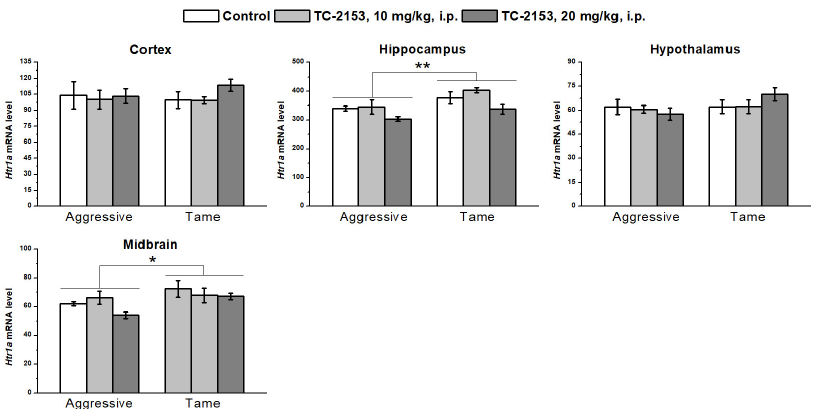
Figure 5. Effects of acute administration of vehicle (control) or TC-2153 at a dose of 10 or 20 mg/kg on 5-HT 1A receptor ( Htr1a ) mRNA levels in the cortex, hippocampus, hypothalamus, and midbrain of aggressive and tame rats. The expression levels were assessed as the number of transcript copies per 100 copies of Polr2a mRNA. * p < 0.05 and ** p < 0.01 for the genotype effect (5–7 animals per group).